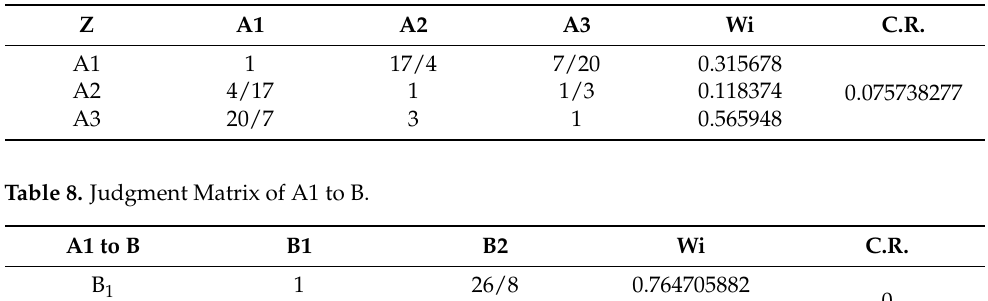
Figure 11. Index system of AHP. Table 7. Judgment Matrix of Z to A.